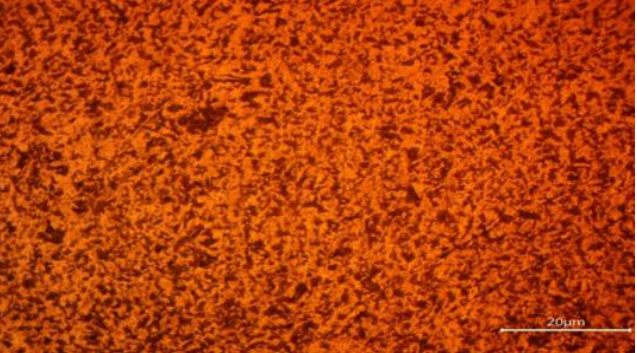
Fig. 6. Microstructural of unwelded annealed medium carbon steel.